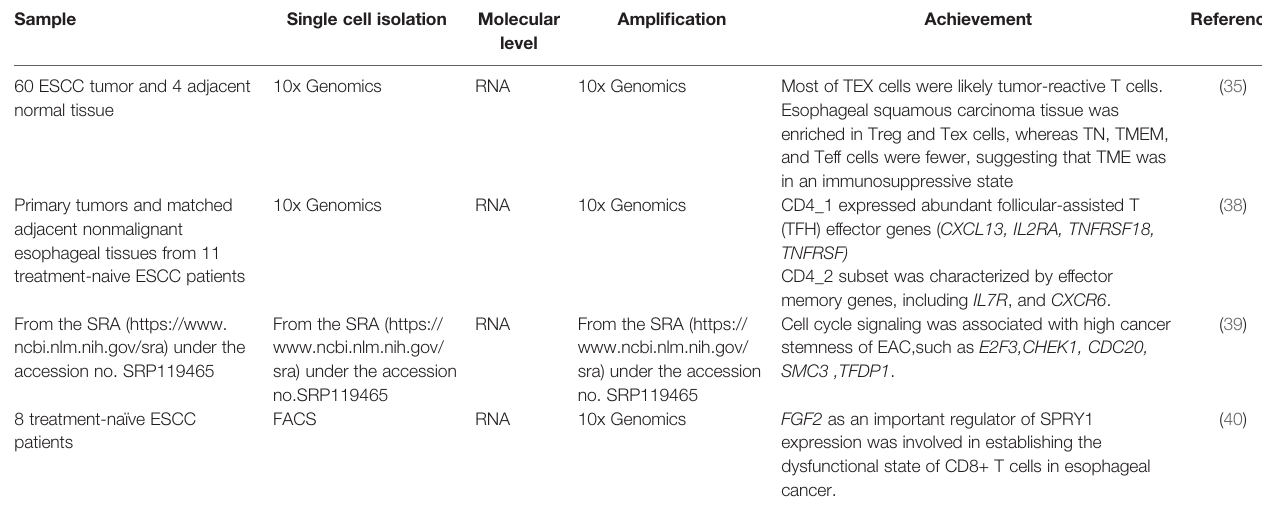
TABLE 5 | SCS in microenvironment of esophageal